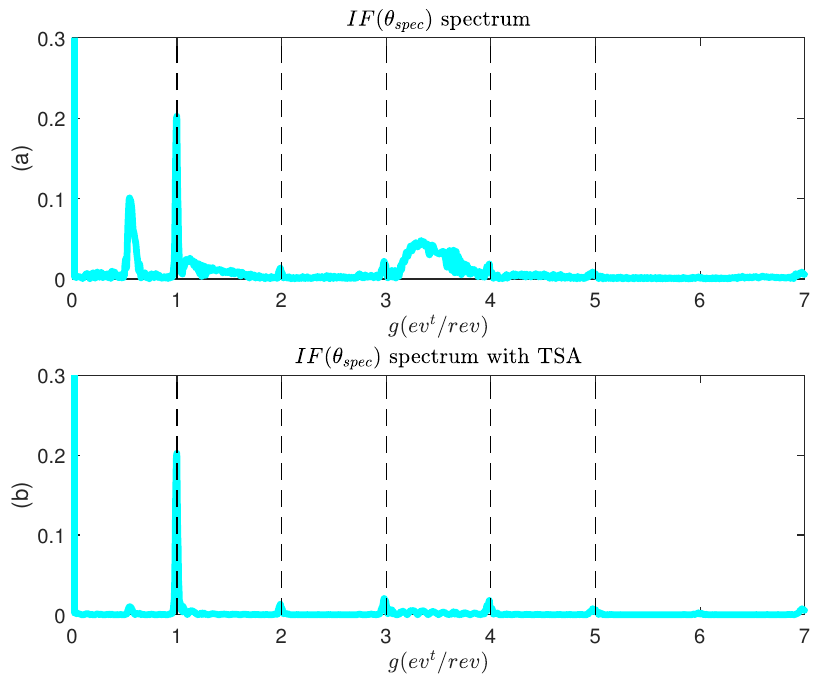
Figure 10. IF ( t ) analysis during